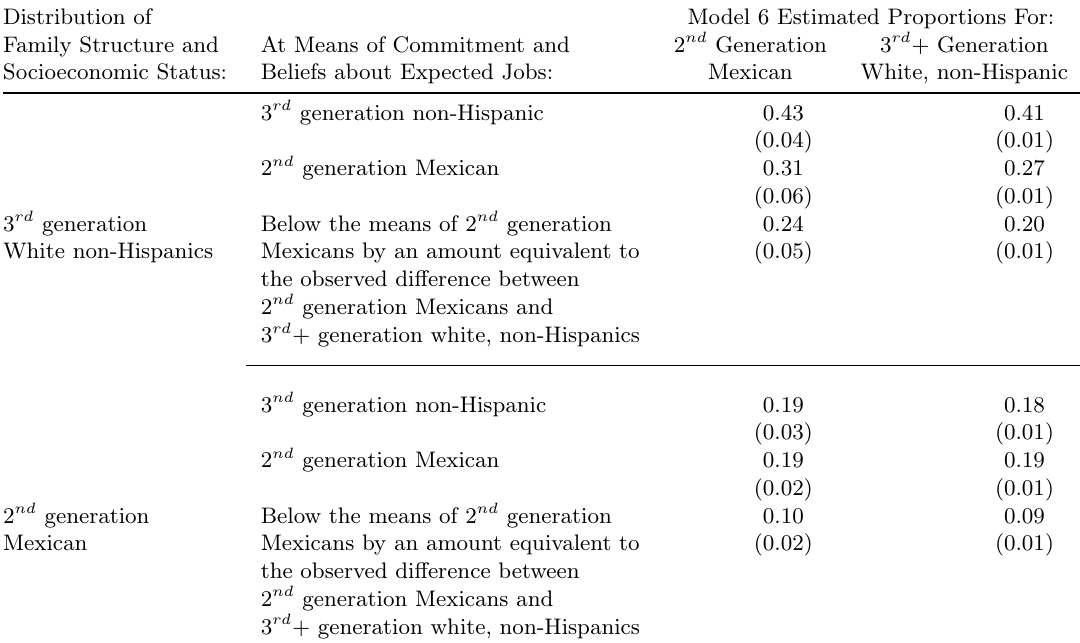
Table 8: Simulated Group Differences from Model 6 for Alternative Assumptions That Predispose toward Acceptance of the Dissonant Acculturation Conjecture for 2 nd Generation Mexican Students Distribution of Model 6 Estimated Proportions